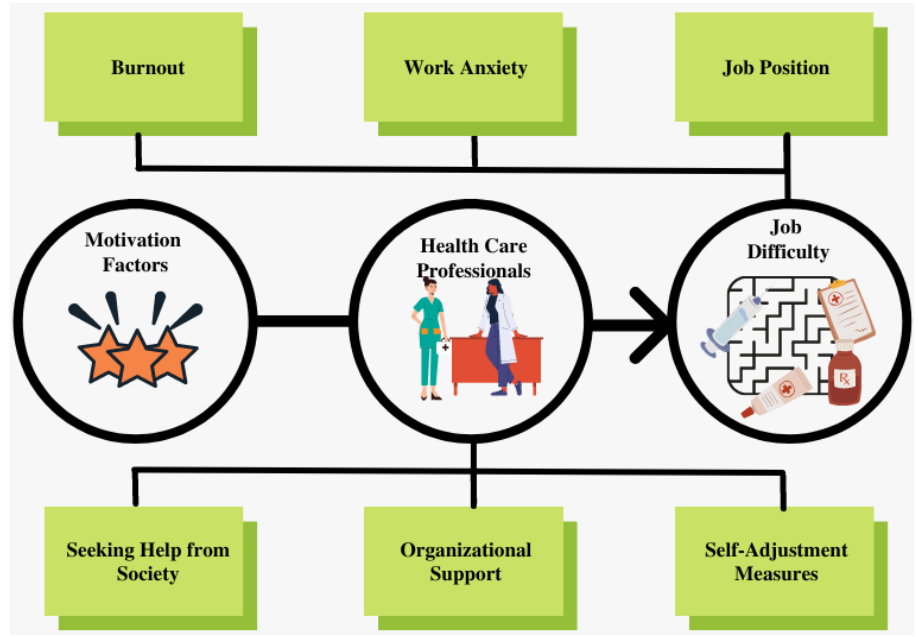
Figure 1. Framework of motivational factors of work environment and solutions to job difficulty perception.